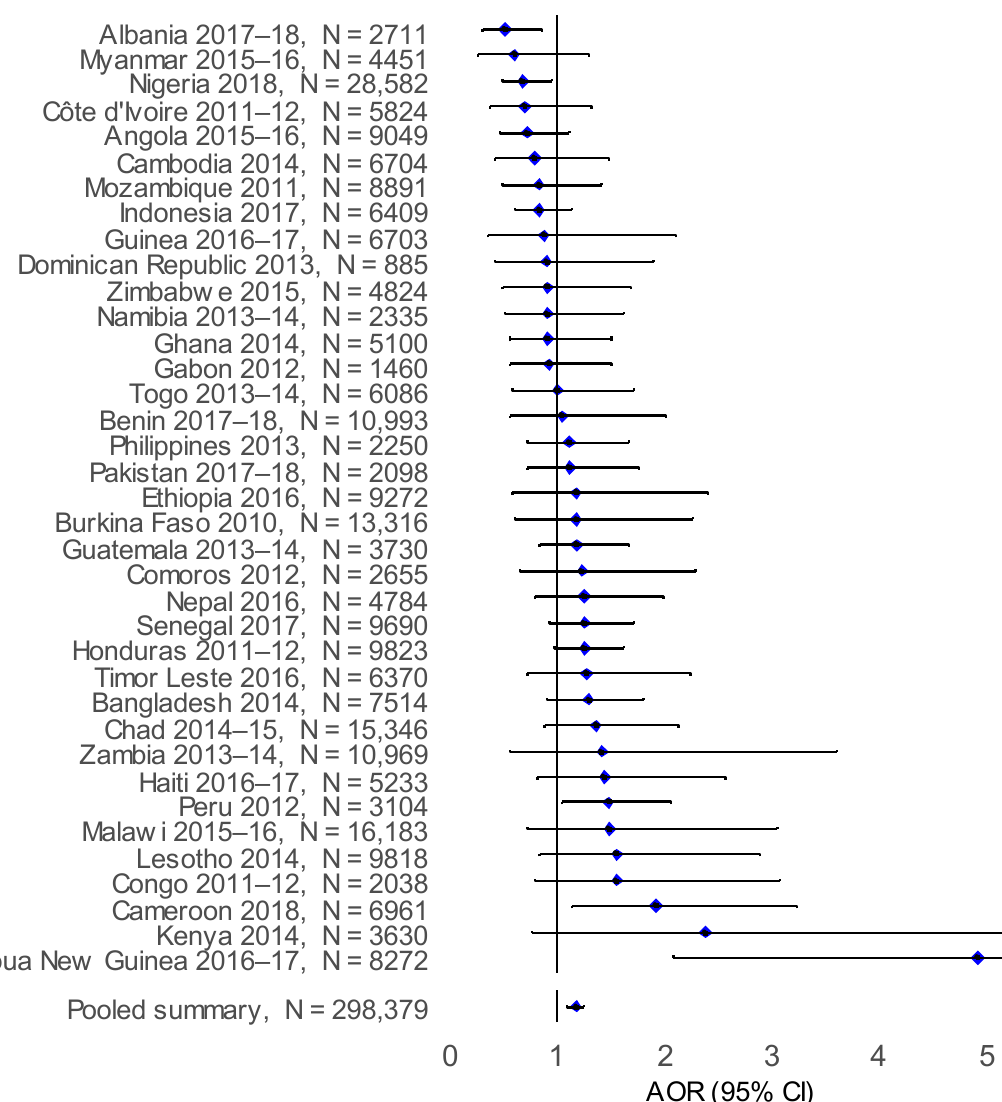
Figure 5. Forest plot for the adjusted odds ratio (AOR) for ARI in children aged under five years with biomass cooking compared to cleaner cooking for all countries.